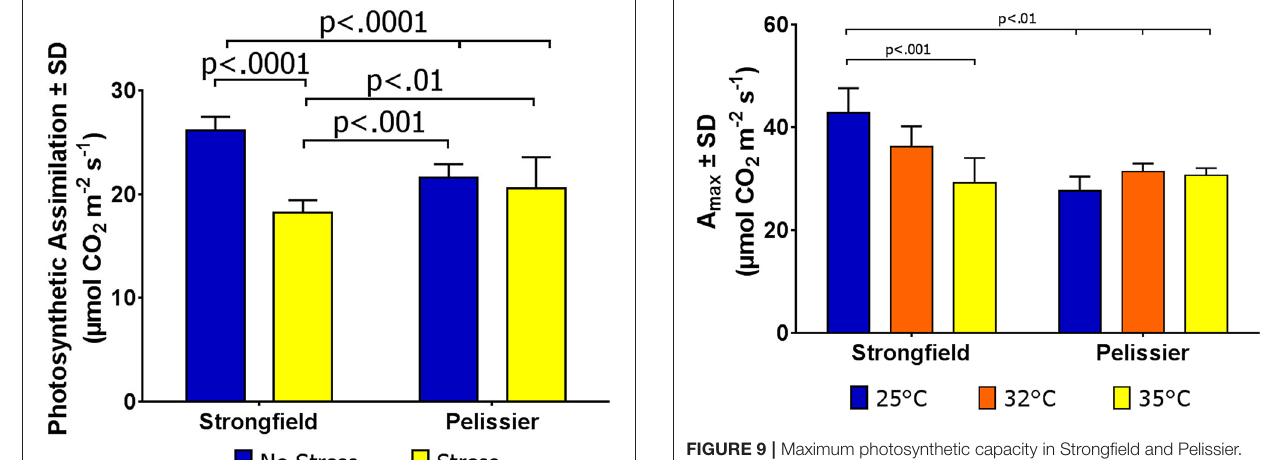
FIGURE 9 | Maximum photosynthetic capacity in Strongfield and Pelissier. A max was determined from light curves on flag leaf under well-watered